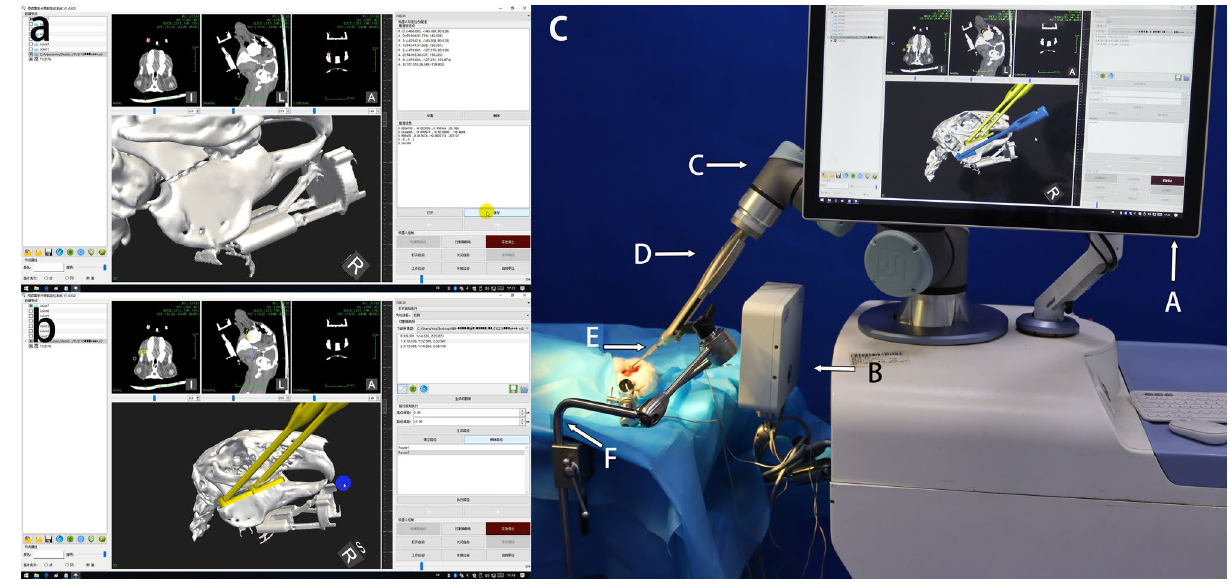
Figure 4. Robotic registration and initial positioning of the template. ( a ) Identification of the steel balls for registration, shown in the software. ( b ) The system calculates the movement path during osteotomy guidance (indicated in yellow), according to the preoperative design. ( c ) Panoramic view of the operating theatre. The robotic arm is ready to reach the target position automatically. The actual position of the template corresponds to the blue part. (A) computer screen, (B) electromagnetic generator, (C) robotic arm, (D) robotic arm sub-end for connection, (E) template, (F)